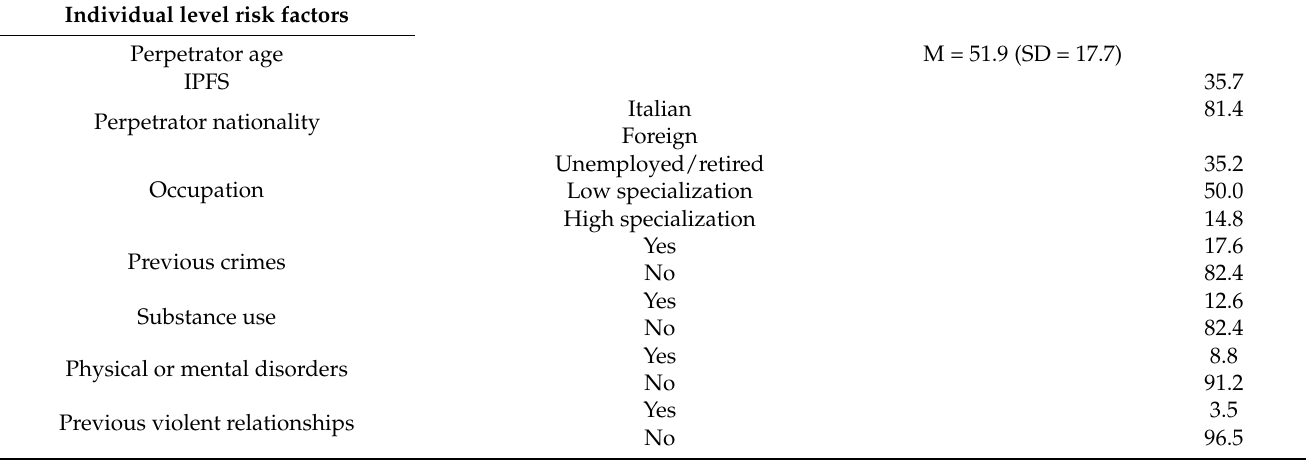
Table 1. Descriptive statistics of risk factors in